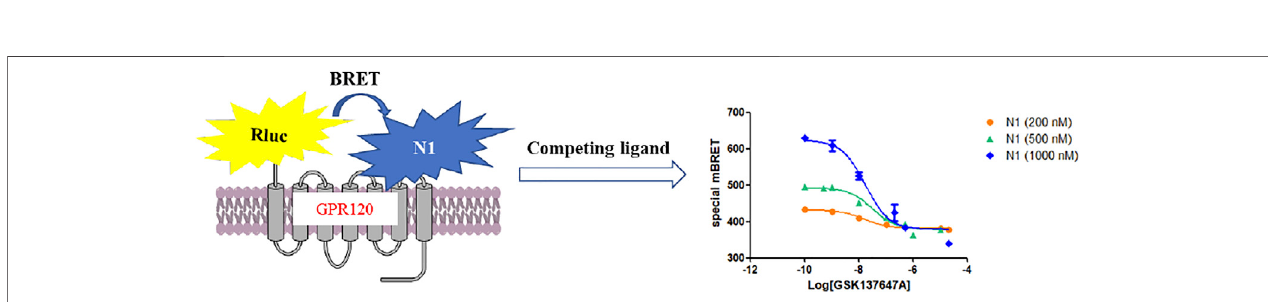
FIGURE 2 | The mechanism of BRET competitive experiment.